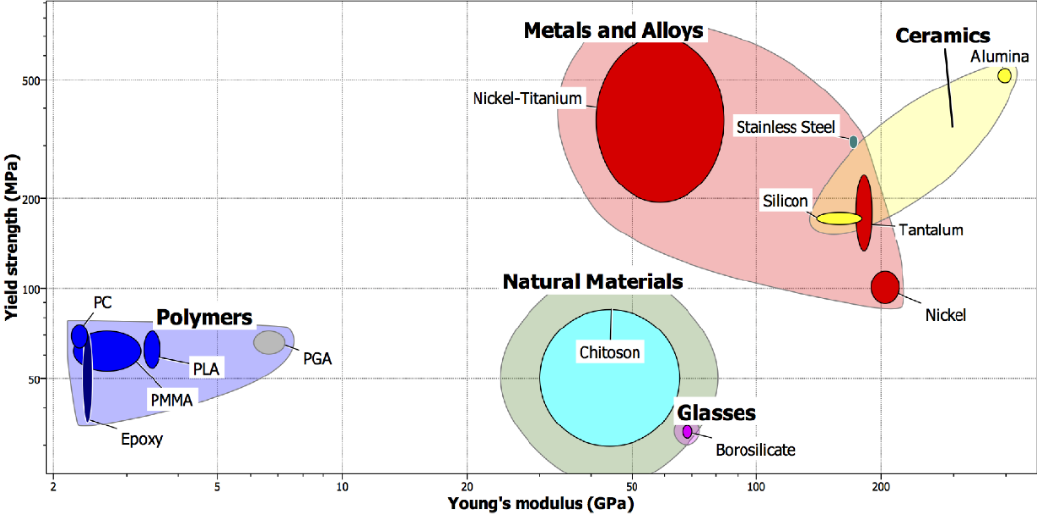
Figure 2. Yield strength vs. Young’s modulus of different materials used for the fabrication of microneedles. Reprinted with permission from [64].